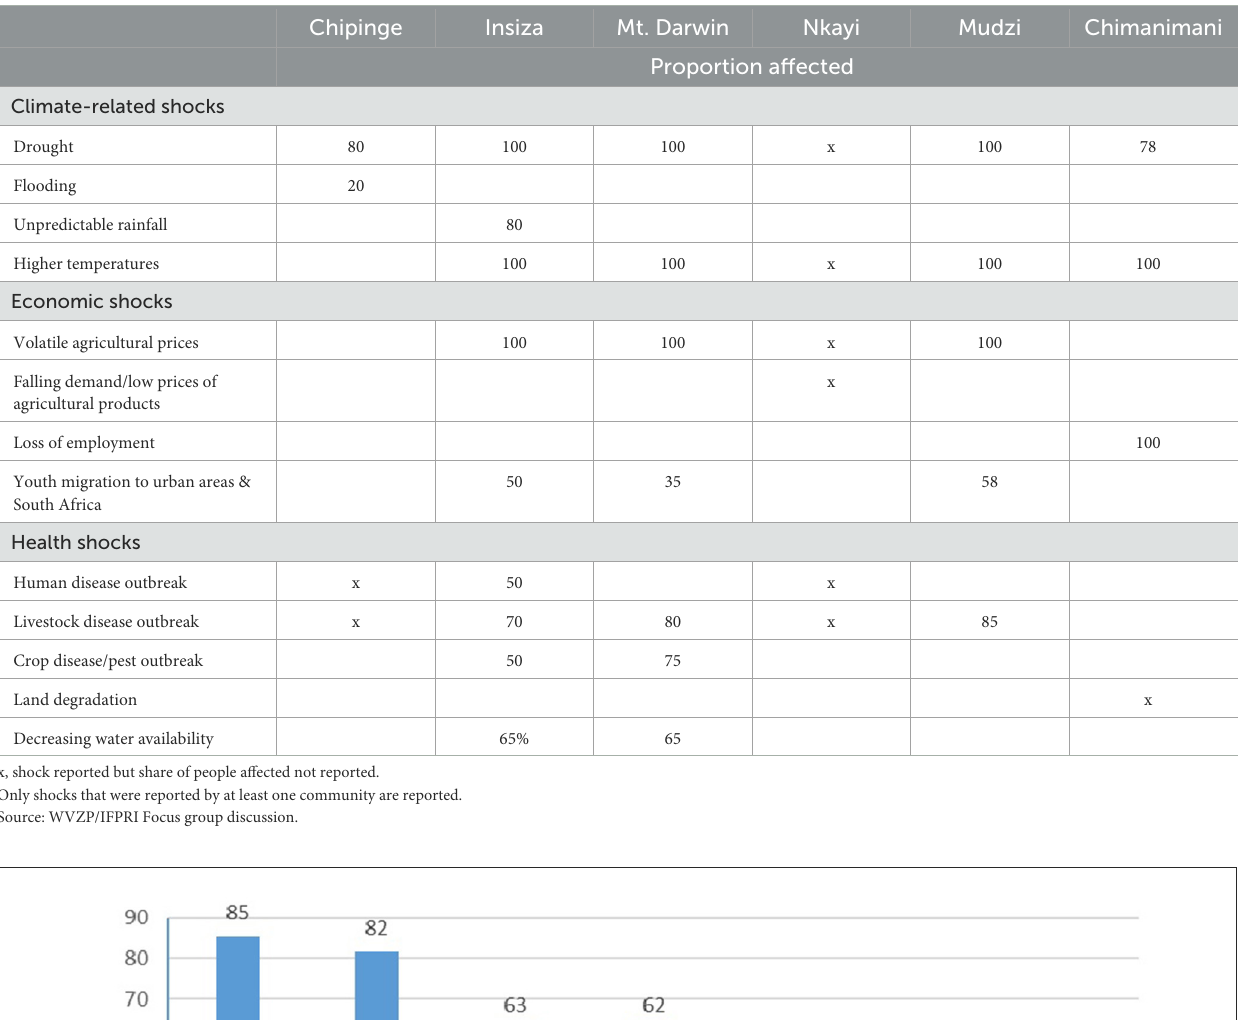
TABLE 5 Shocks and stressors in the past 5 years.